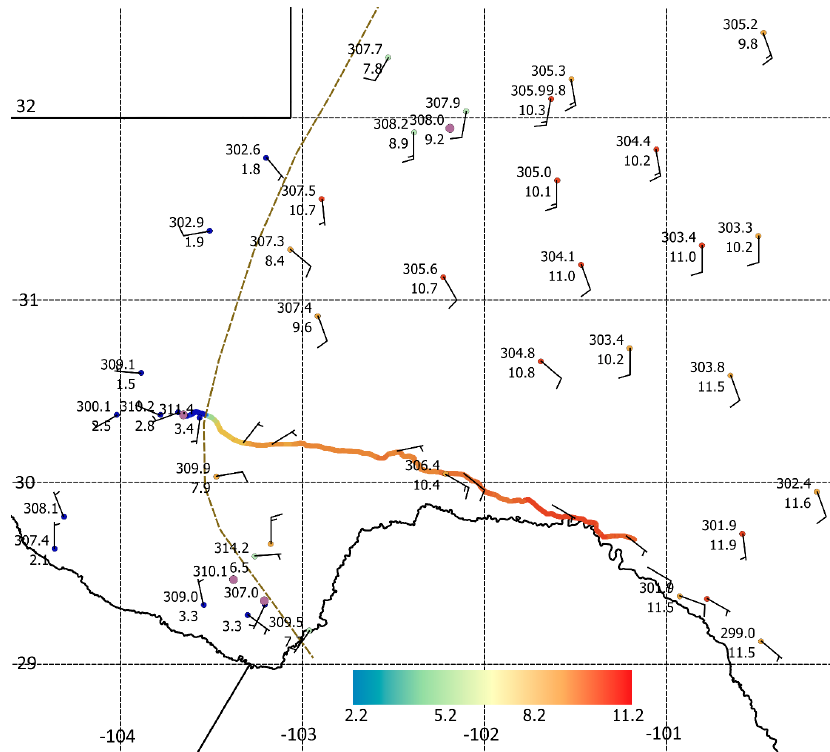
Figure 6. Surface observations at 0300 UTC, with virtual potential temperature (upper left; K) and mixing ratio (bottom left; g/kg). Mobile observations of mixing ratio (blue = low values; red = high values) are shown from Comstock to Alpine.